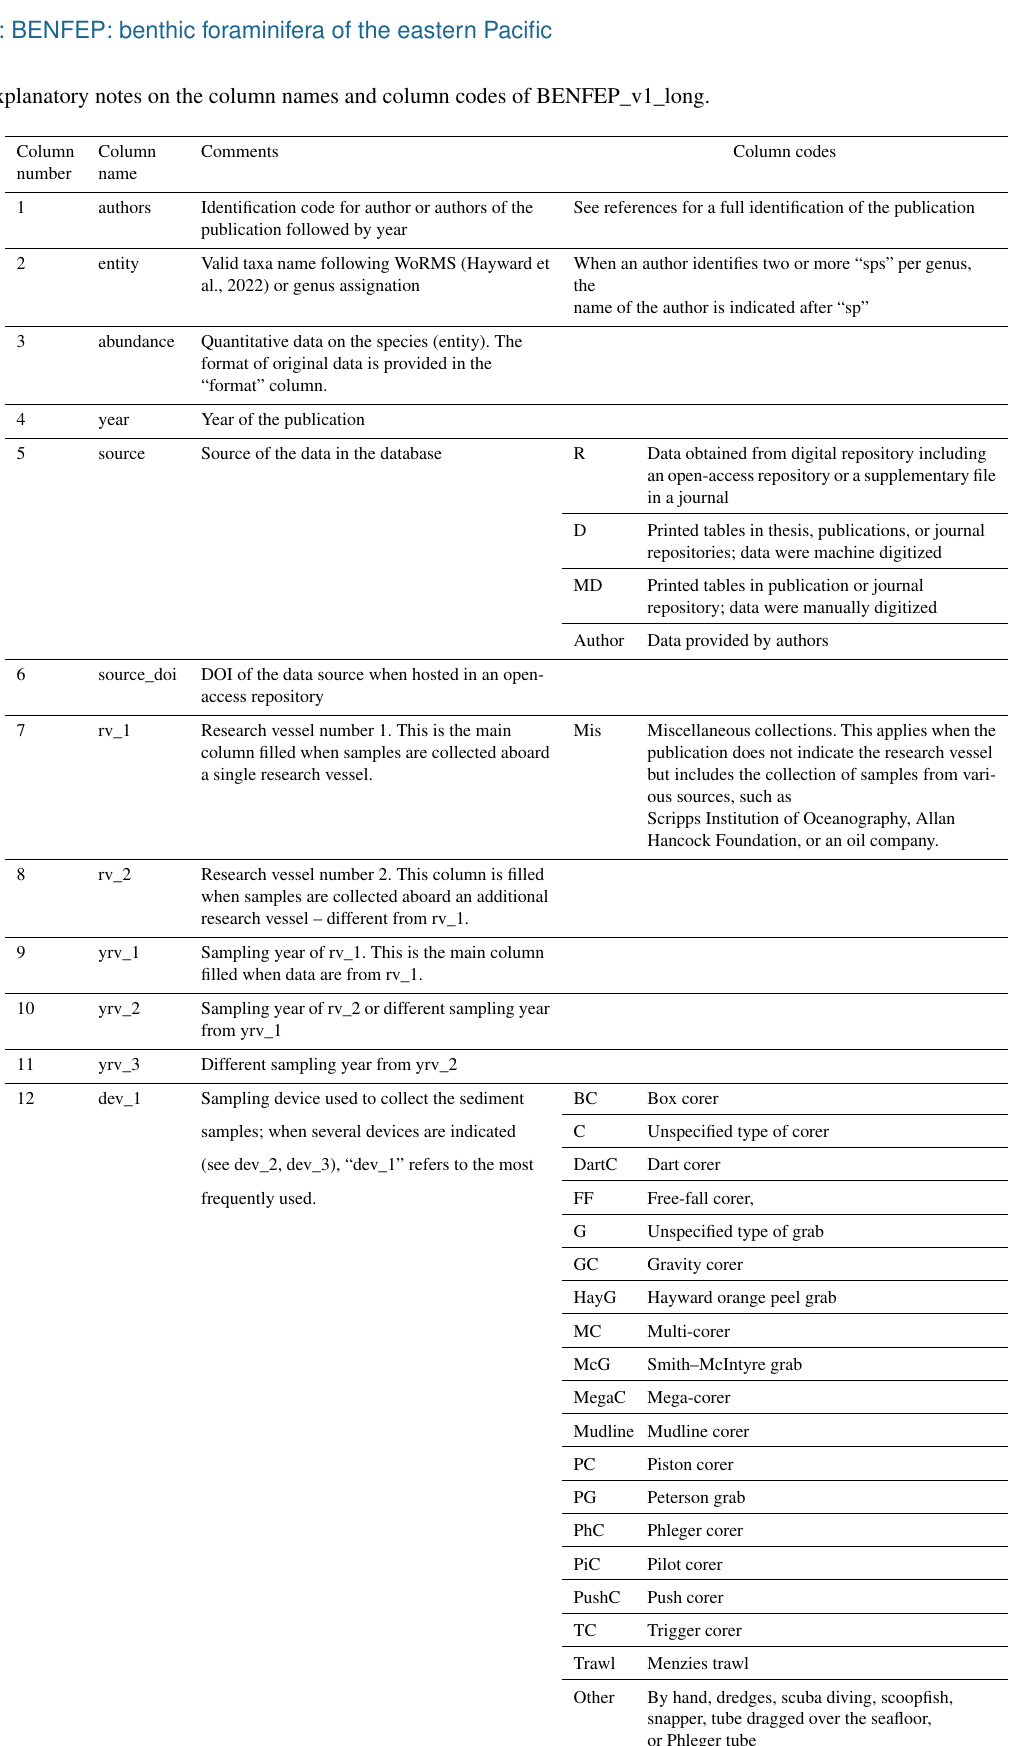
Table C2. Explanatory notes on the column names and column codes of BENFEP_v1_long. Column